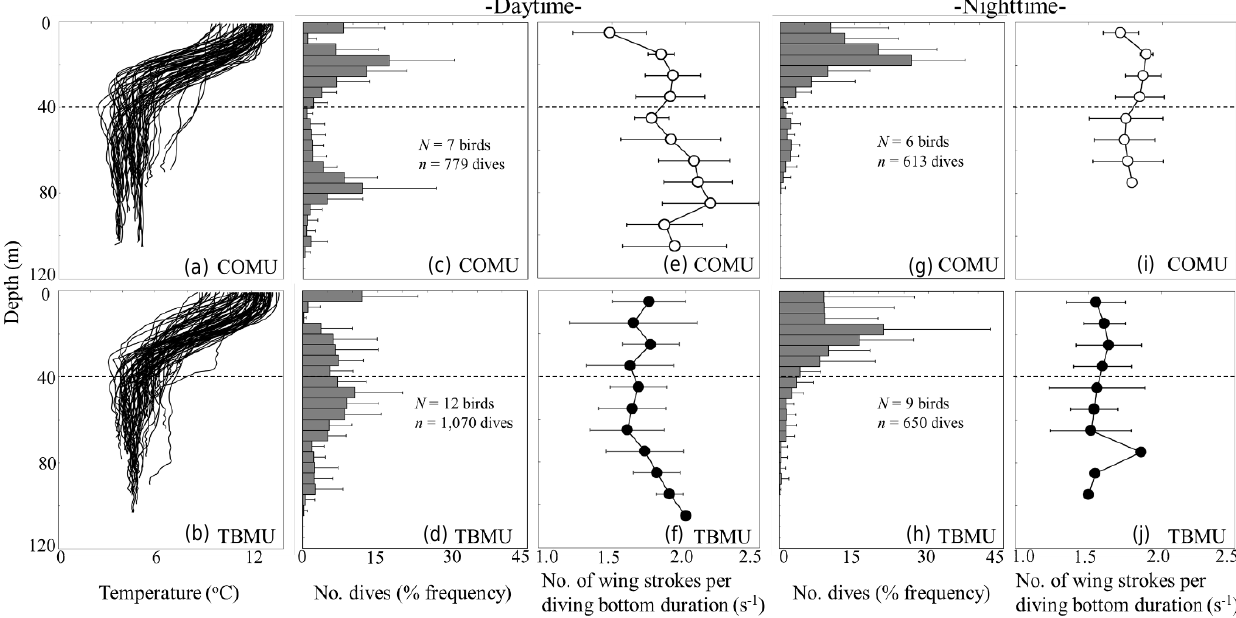
Figure 3. (a, b) Vertical temperature profiles where foraging dive occurred with (c, d, g, h) frequency distribution of dives and (e, f, i, j) number of wing strokes per diving bottom phase, in relation to dive depth. Upper panels represent data for common murres (COMU) and lower panels represent data for thick-billed murres (TBMU). Panels (c) , (d) , (e) , and (f) represent data for the daytime, and panels (g) to (j) represent data for the nighttime. Means ± standard deviation (SD) are shown, except for (a) and (b) , which are calculated from individual bird data. Sample number of birds ( N) and dives ( n ) are shown in (c) to (h) .